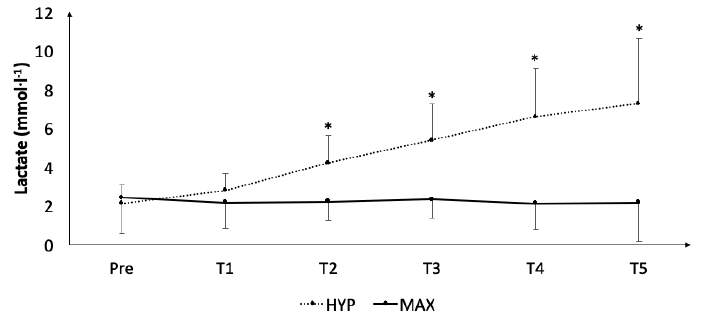
Figure 5. Acute accumulation of blood lactate concentrations throughout both protocols. *, statistically significant difference to baseline ( p < 0.05).